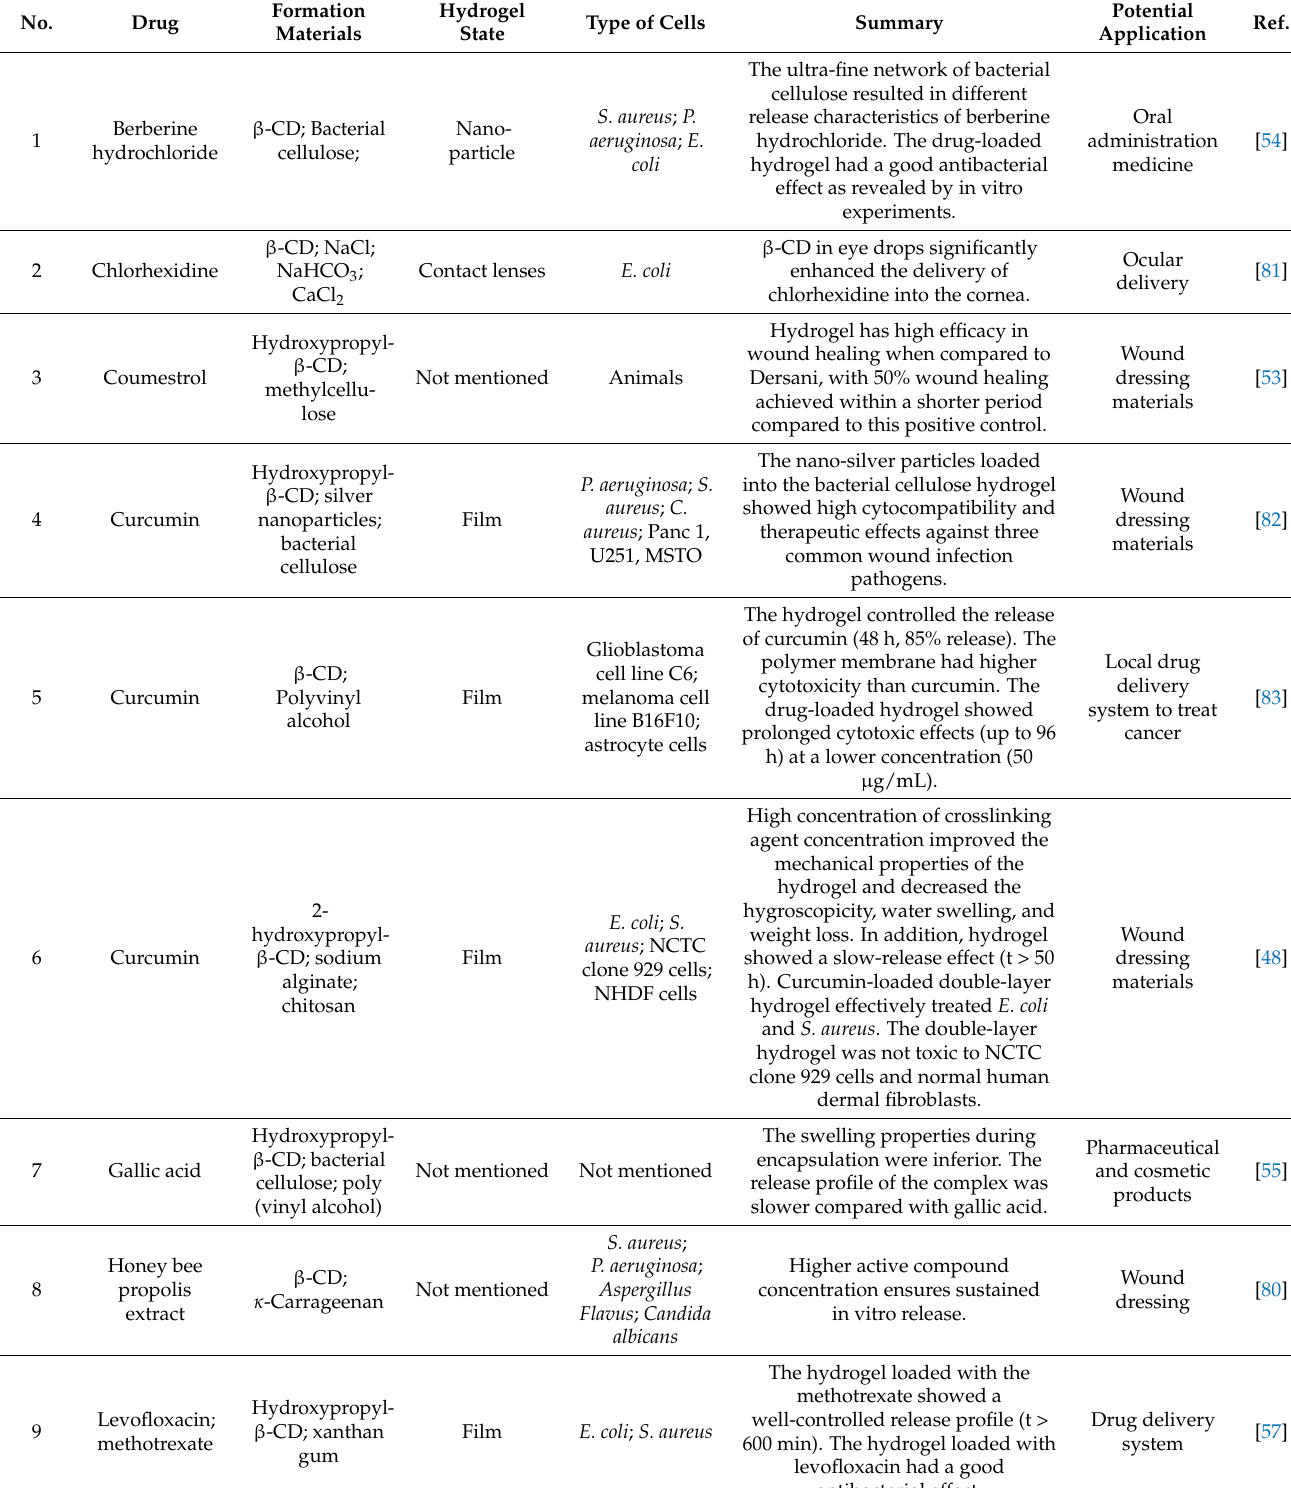
Table 4. Potential application of physically cross-linked CD-containing